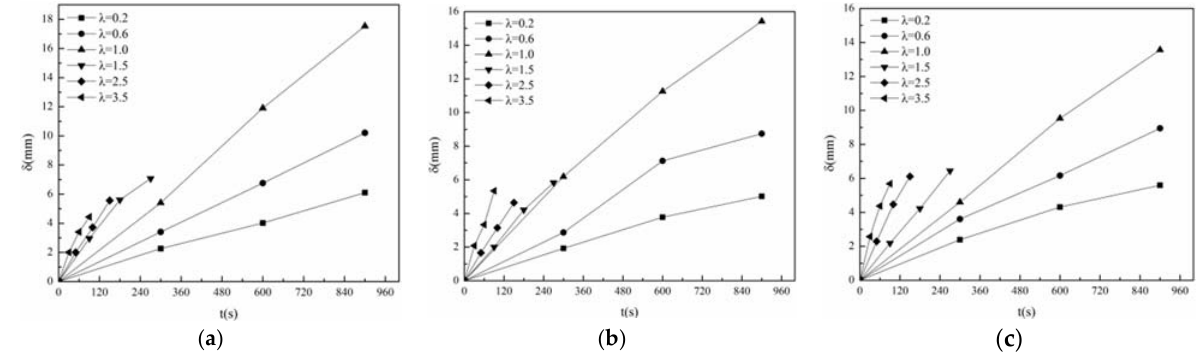
Figure 11. Variations of the stagnation point thickness with the icing time: ( a ) d = 20 mm; ( b ) d = 30 mm; ( c ) d = 40 mm.